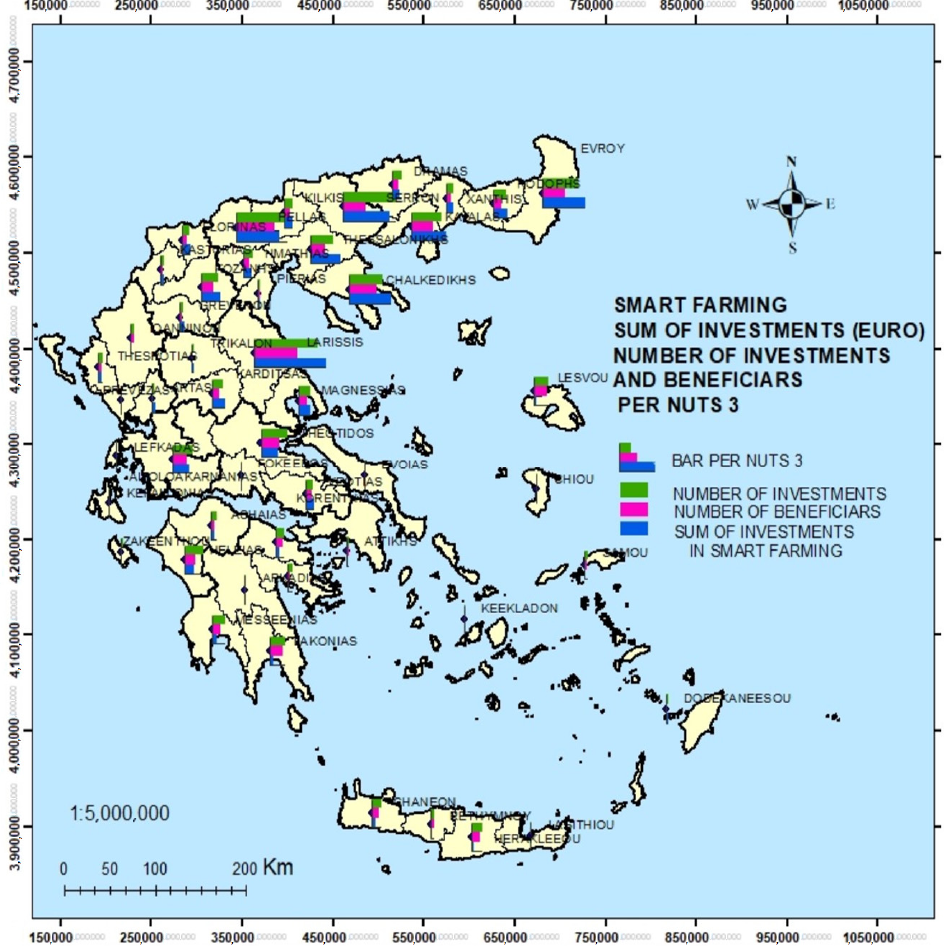
Figure 3. Spatial distribution of SF investments (SFIs) in Greece (normalization of values by feature scaling, depicted own elaboration in ESRI ArcGIS Desktop 10.5-ESRI 2016. ArcGIS Desktop: Release 10.5, Redlands, CA: Environmental Systems Research Institute).